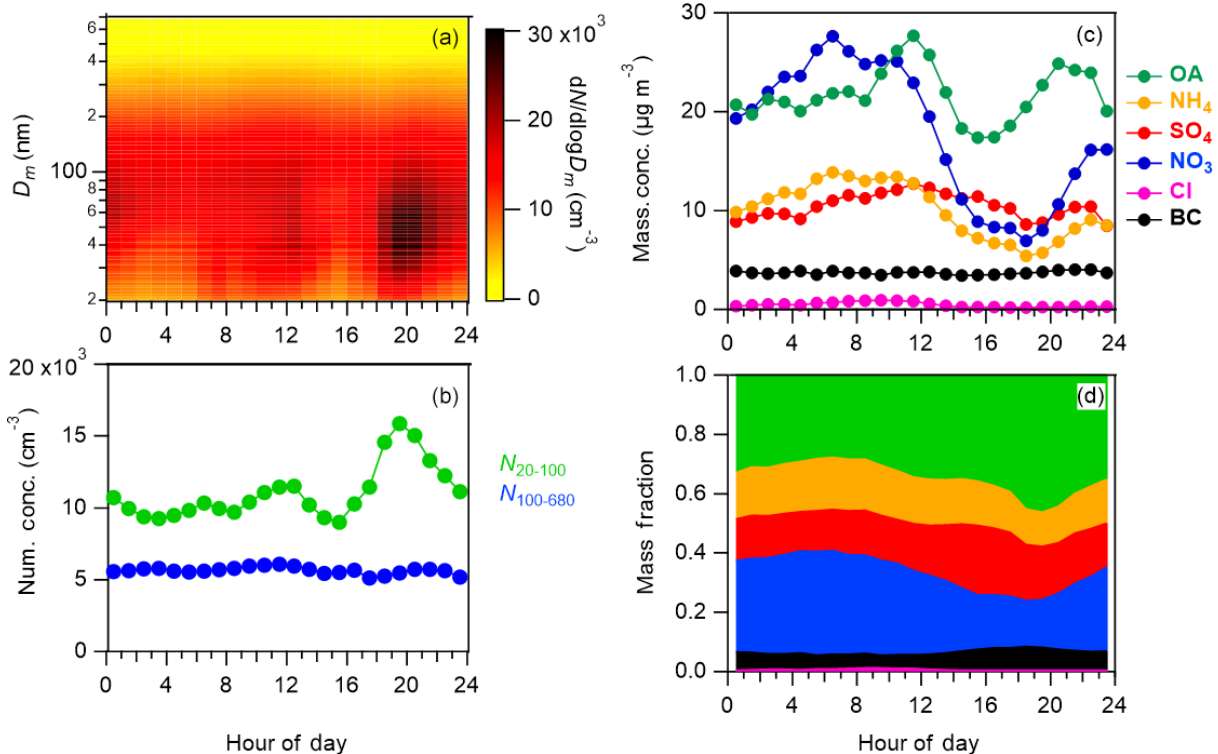
Figure 4. Average diurnal evolution of particle number size distribution during non-NPF days. (a) Particle size distribution, (b) number con- centrations of particles in N 20–100 (20–100nm) and N 100–680 (100–680nm), (c) different component concentrations and (d) mass fractions of different components. Average diurnal evolution of all days (NPF days are also included) is also presented in Fig. S1 in the Supplement.